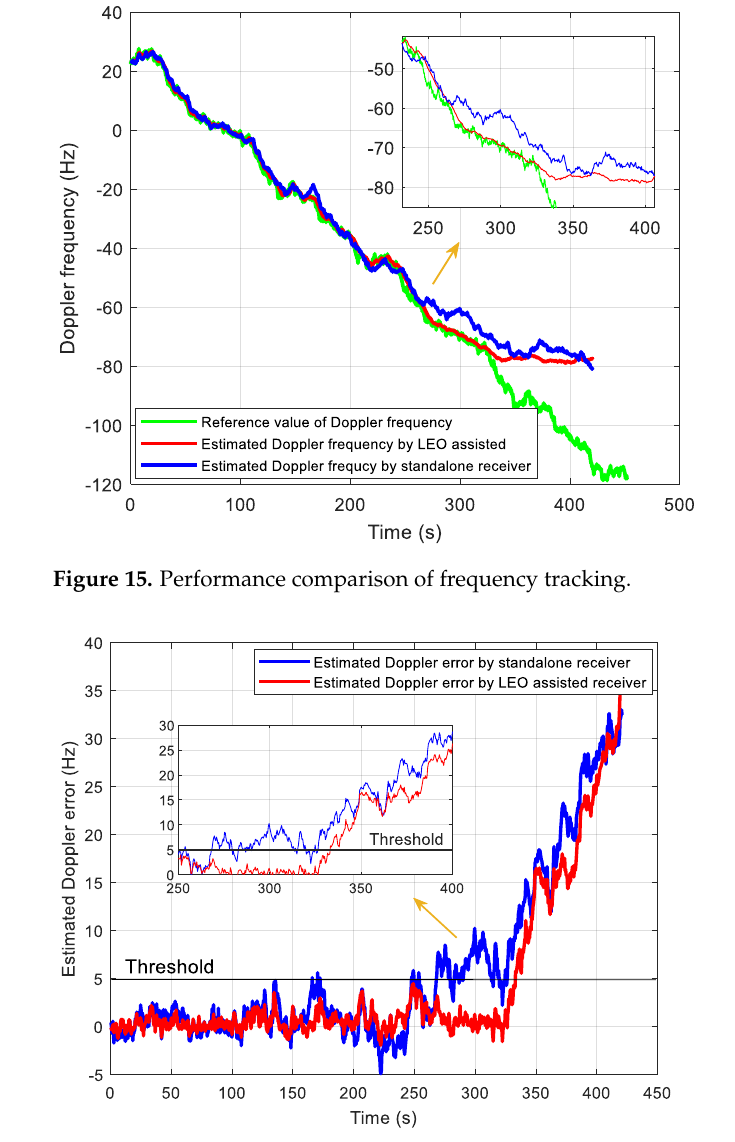
Figure 16. Performance comparison of estimated Doppler error.